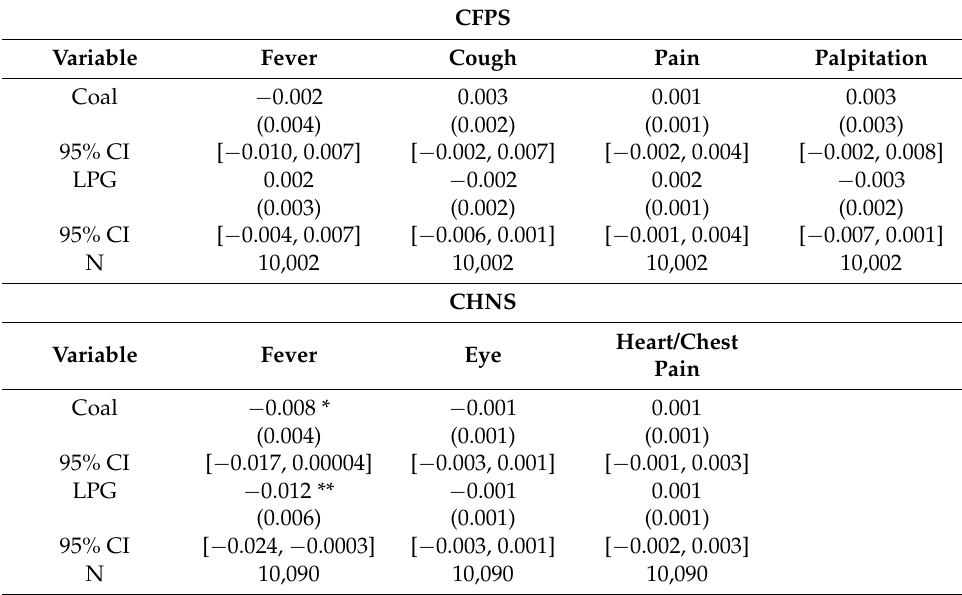
Table 9. Random effects probit estimates for the effect of domestic cooking fuels on women’s health (specific symptoms) in rural areas: CFPS 2010–2012 & CHNS